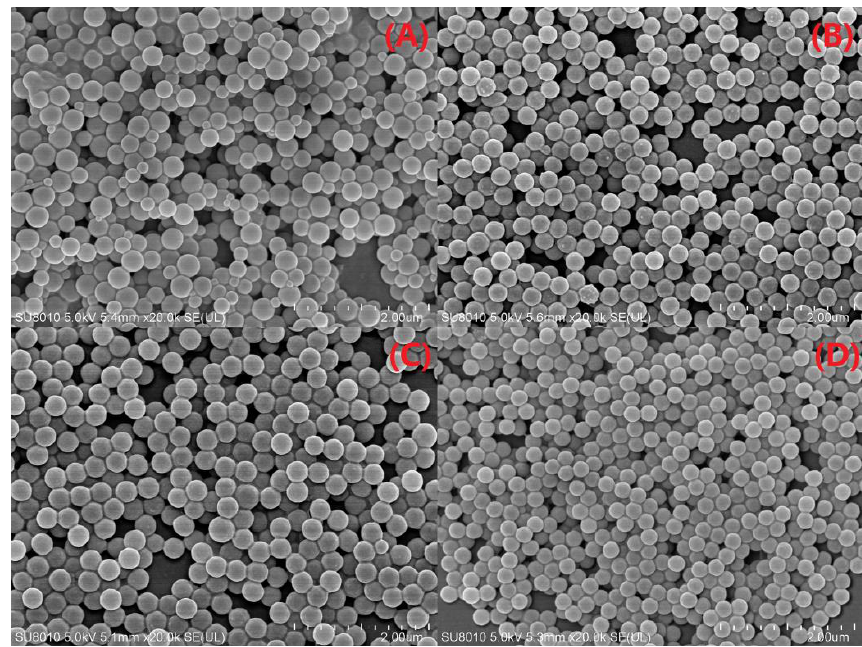
Figure 9. SEM images of ( A ) PS, ( B ) PS/P-MMT, ( C ) PS/P-SLS-MMT, and ( D ) PS/P-KH570-MMT.